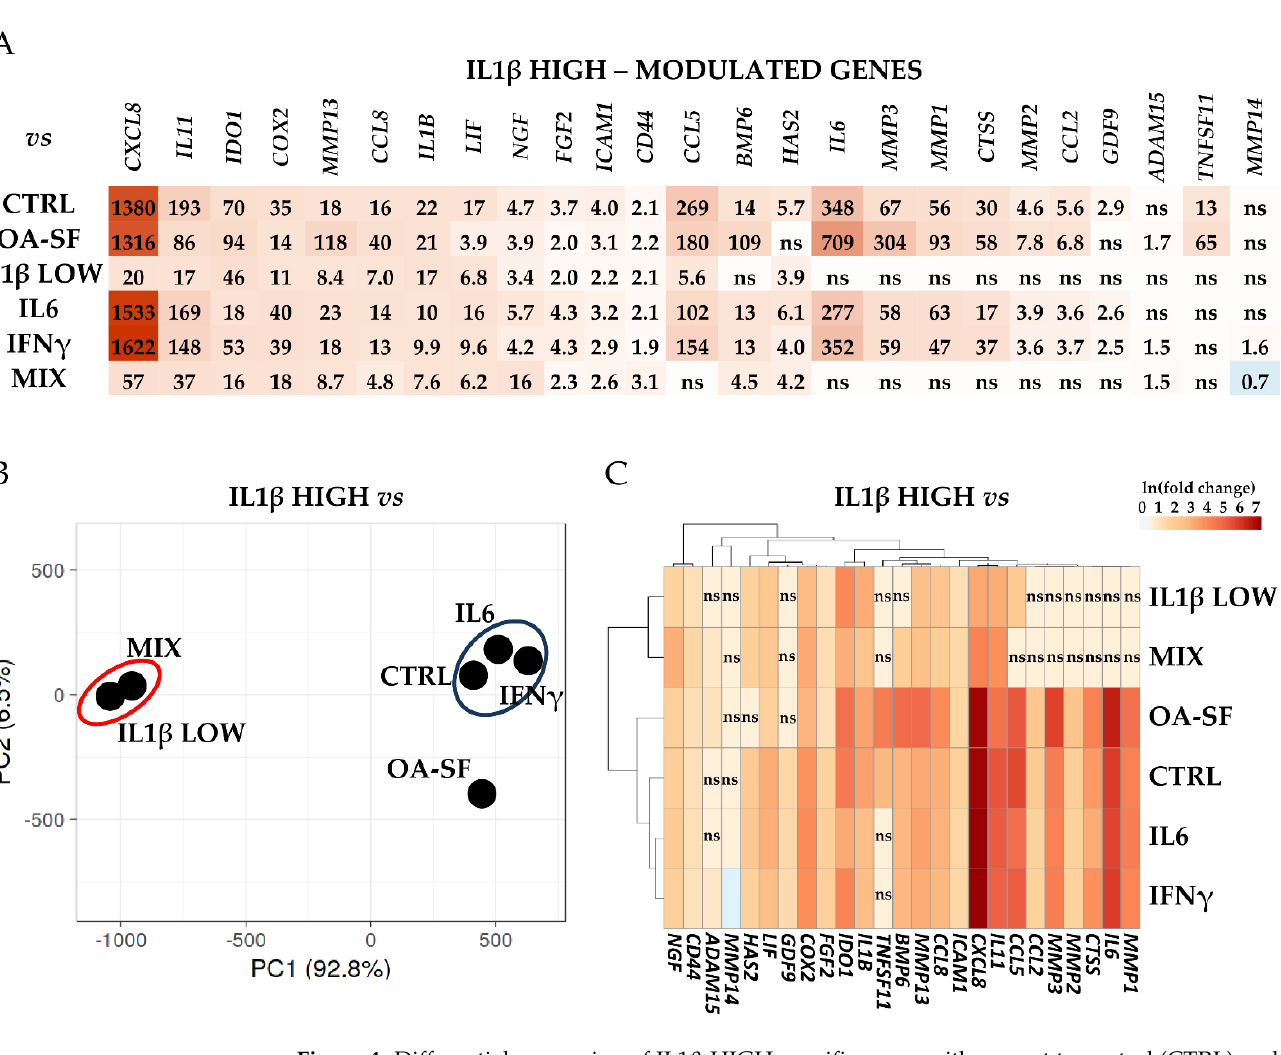
Figure 4. Differential expression of IL1 β HIGH-specific genes with respect to control (CTRL) and the other stress treatments (abbreviations as in Figure 2) in the three HCH donors. ( A ) Red shades indicate higher expression ratios and blue shades indicate lower expression ratios of IL1 β HIGH with respect to the other conditions. Color key indicates the intensity associated with expression ratios. Mean values are shown. ns = not statistically significant ( p -value > 0.05). p -value for each shown ratio can be found in Supplementary Table S4. ( B ) PCA based on the expression ratios of IL1 β HIGH with respect to the other conditions. ( C ) Heatmap based on the ln transformed expression ratios of IL1 β HIGH with respect to the other conditions. Red shades indicate higher expression ratios and blue shades indicate lower expression ratios. Color key indicates the intensity associated with expression ratios. ns = not statistically significant (p-value > 0.05).